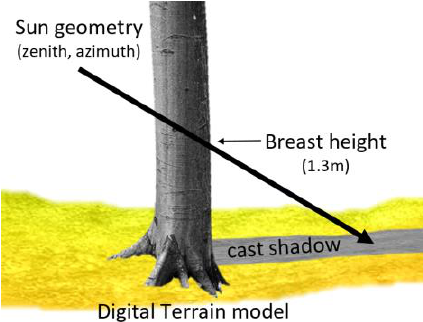
Figure 5. Scheme showing the projection of the DBH position (at 1.3 m height) on the ground (DTM).